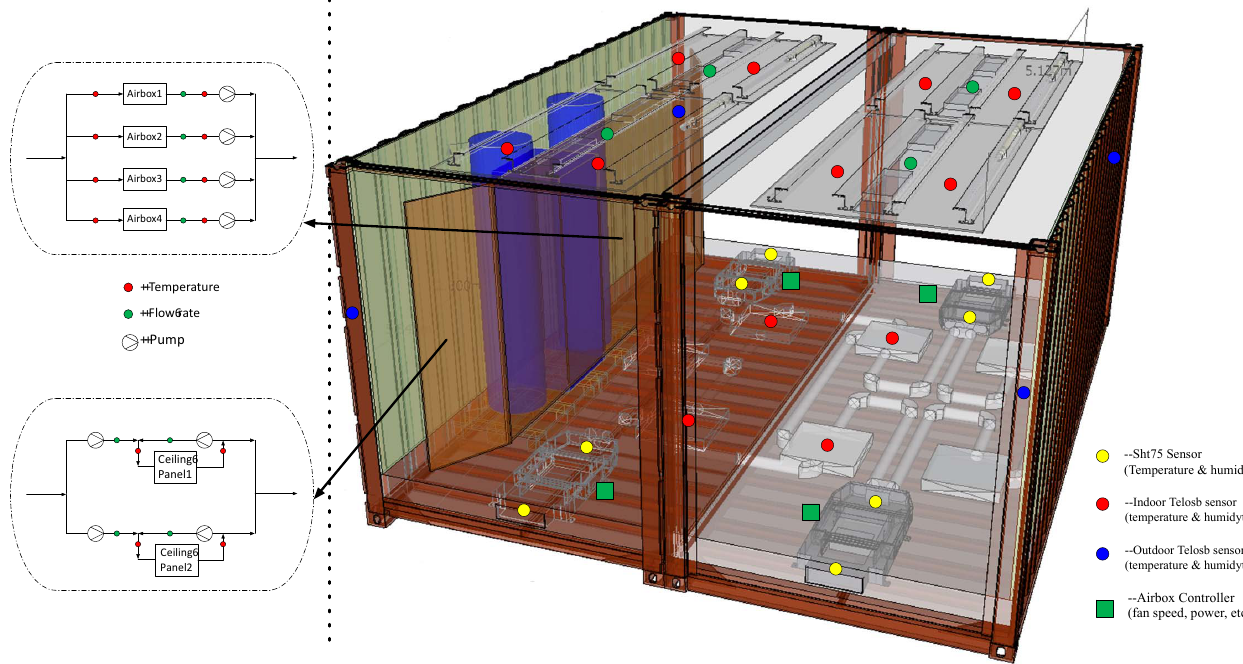
Figure 6. Schematics of sensor deployment within